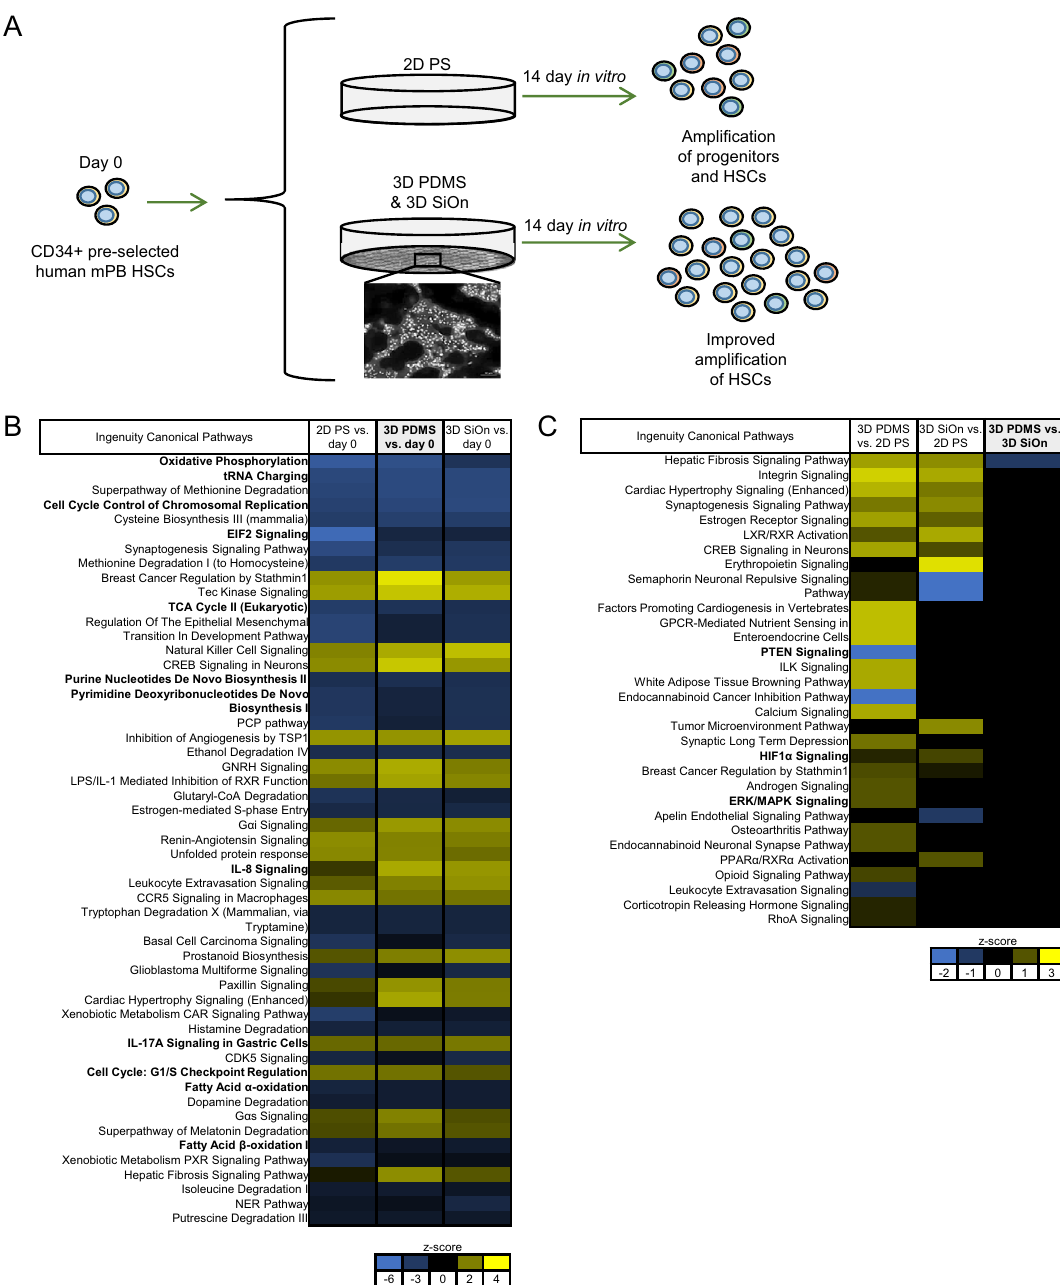
Figure 1. ( A ) Graphical summary of the in vitro cell culture system used in this study. CD34+ pre-selected human hematopoietic stem cells from mobilized peripheral blood (mPB HSCs) were cultivated for 14 days in vitro within an optimized HSC culture medium [supplemented with a panel of cytokines and valproic acid (VPA)]. HSCs were grown either on standard 2D polystyrene (PS), or on non-coated as well as silicon oxide (SiOn)-coated 3D polydimethylsiloxane (PDMS) cell culture scaffolds mimicking the natural bone marrow (BM) structure and stem cell niche to expand high amounts of undifferentiated HSCs during ex vivo culture. ( B – C ) The transcriptome of the initial HSC population at day 0 and after 14 days in vitro on 2D PS, 3D PDMS and 3D SiOn scaffolds was analyzed by RNA sequencing (with 3 replicates per group), and the data sets were post-analyzed using ingenuity pathway analysis (IPA). ( B ) Activation of cellular pathways (top 50) after 14 days in vitro on 2D PS, 3D PDMS and 3D SiOn scaffolds compared to day 0 (analysis cutoff: q < 0.05, log2-fold change > 1) and ( C ) activation of cellular pathways (top 30) after 14 days in vitro in comparison between 2D PS, 3D PDMS and 3D SiOn scaffolds (analysis cutoff: q < 0.05) is indicated by corresponding z-scores (blue inactivation/yellow activation) and ranked by the − log(p-value) of individual pathways (most significant at the top). Important pathways/molecules are highlighted with bold